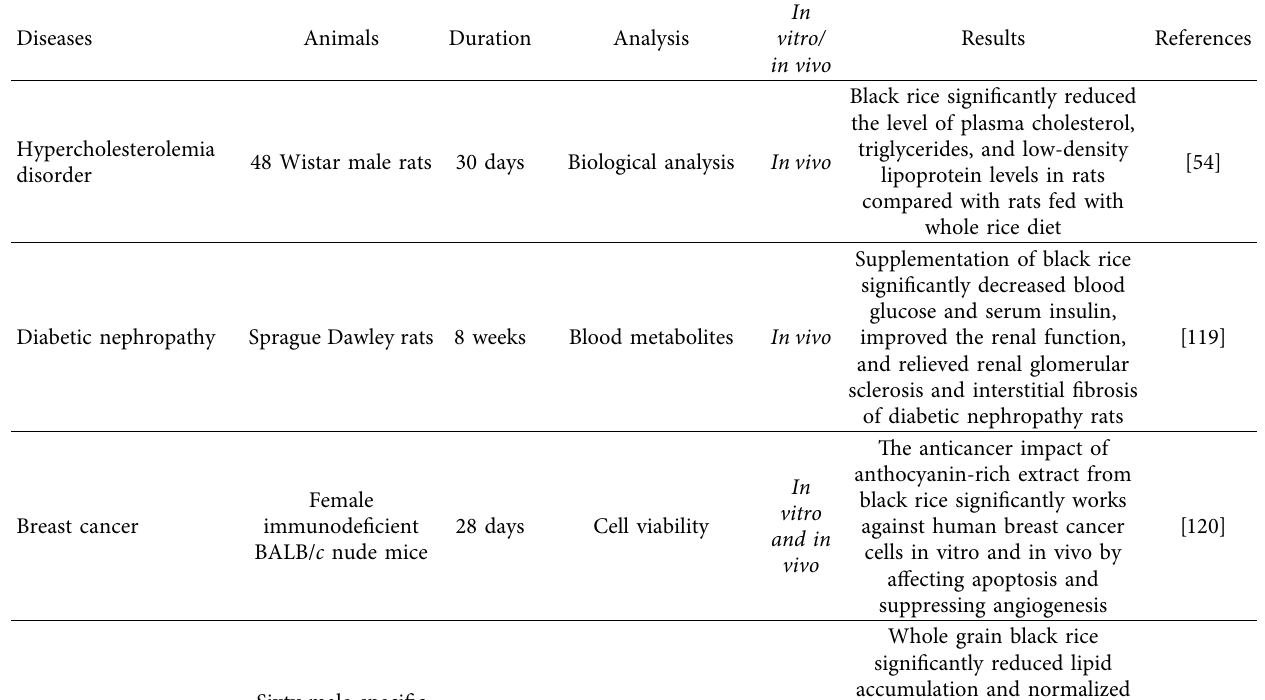
Table 3: Role of black rice against various